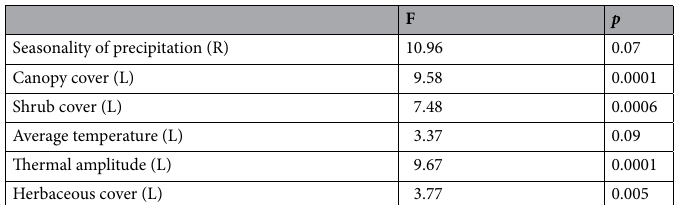
Table 3. Role of local (L) and regional (R) environmental variables in an RDA analysis, explaining the functional structure of dung beetle assemblages in native forest and two livestock systems (forest with cattle and open pasture) in subtropical forests of Argentina (Atlantic Forest, Humid and Dry Chaco). Degrees of freedom: 1.